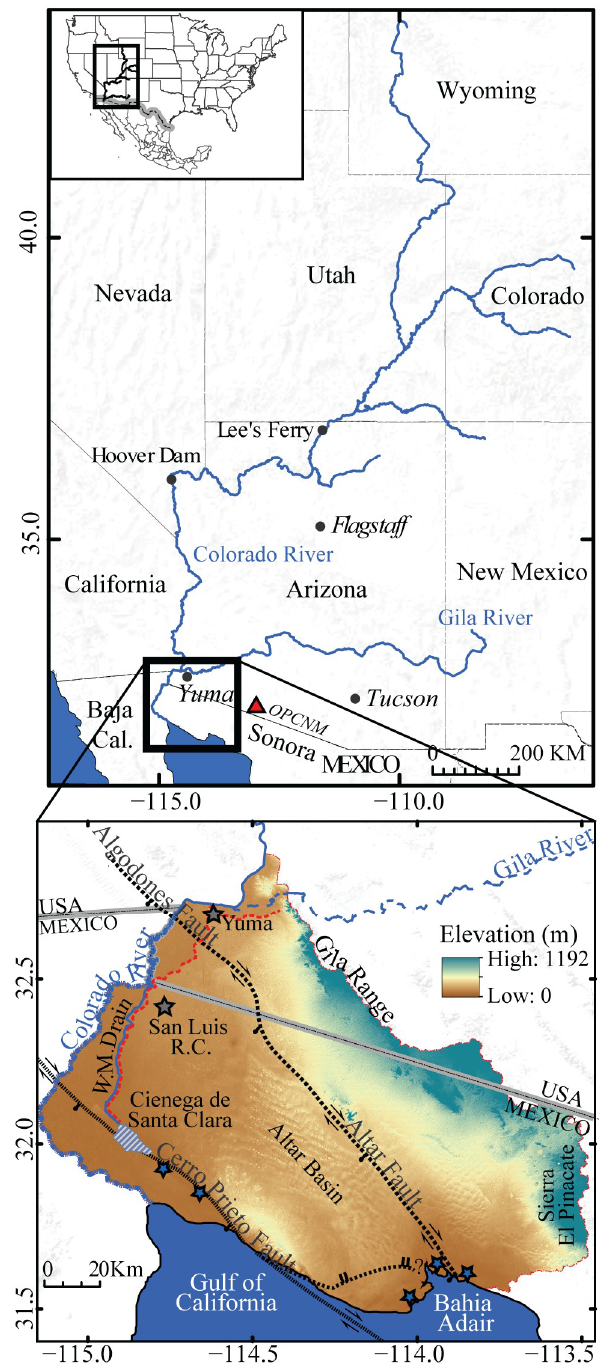
Figure 1. Location of the Colorado River delta, Altar Basin, and major geographical and geological features. Organ Pipe Cactus National Monument (OPCNM, discussed below) is located ~100 km northeast from the study area and is shown as a red triangle in the upper map. The dashed red line in the bottom map separates the floodplain (west) from the Yuma and San Luis mesas (east). The dashed blue line labeled the Gila River represents a dry river bed. Blue stars in the bottom map show the general location of the pozos.